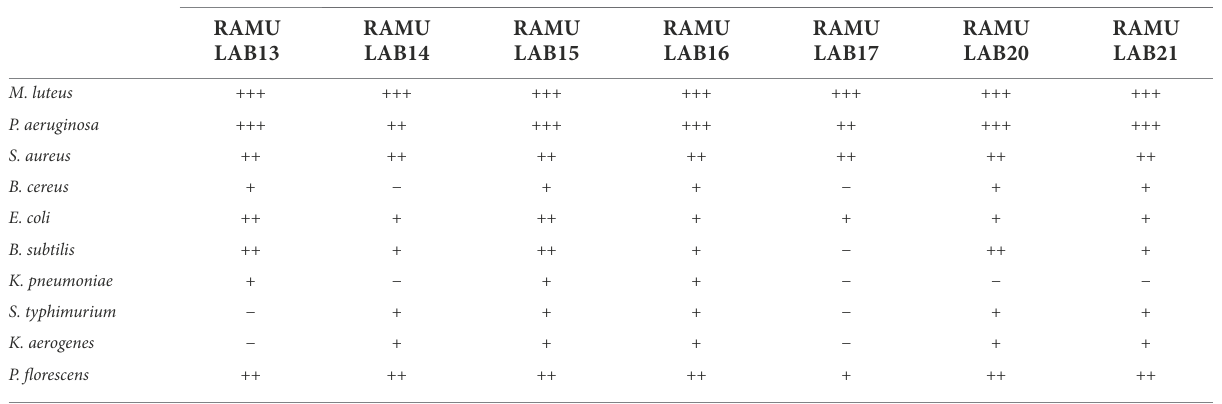
TABLE 5 Antimicrobial activity of the LAB isolates against pathogens. Pathogens